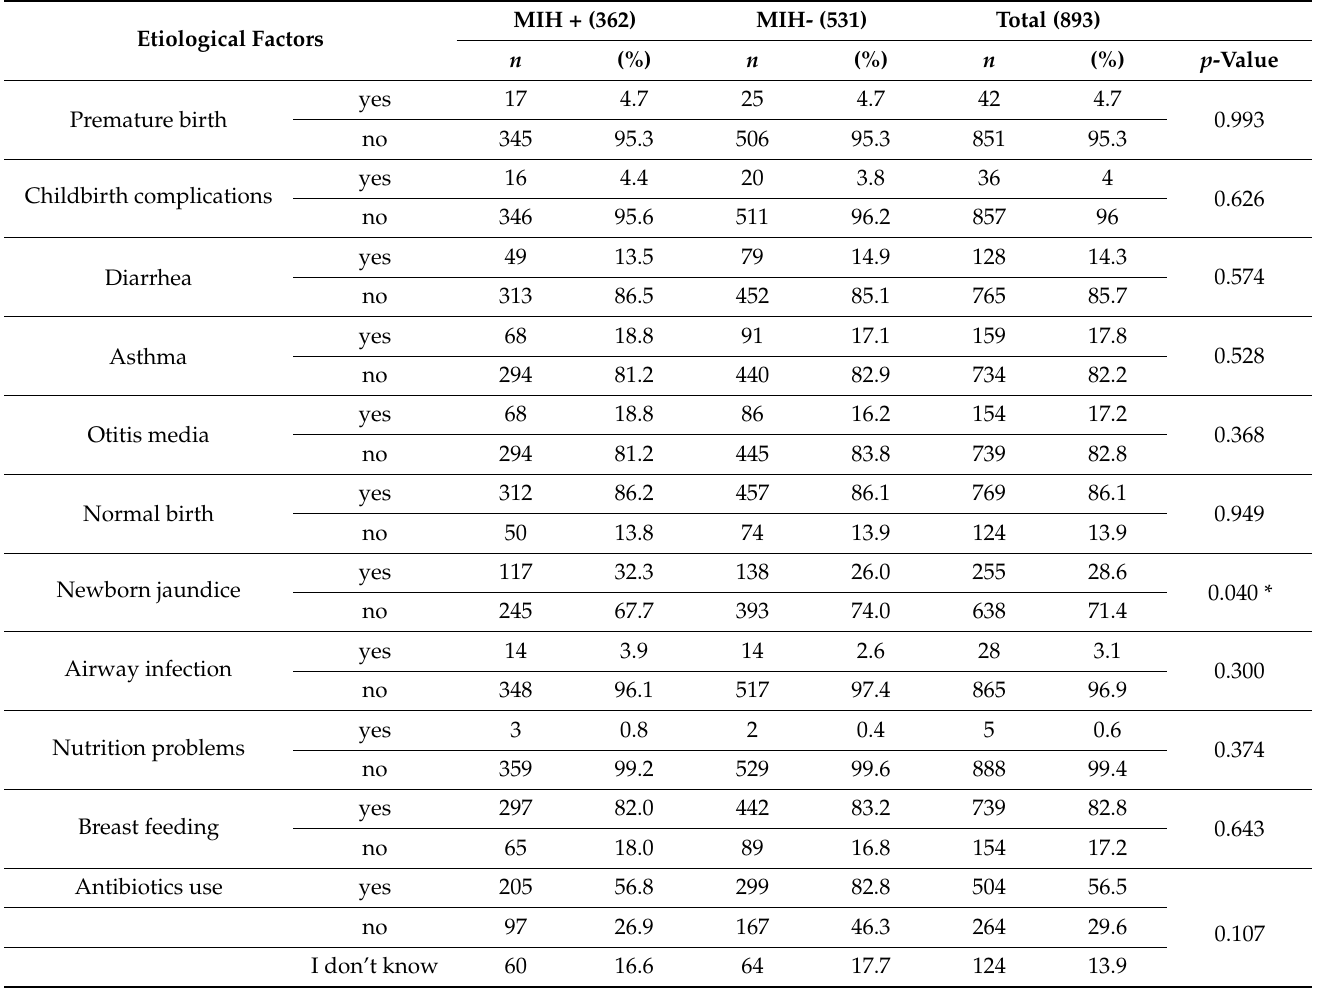
Table 3. Distribution of etiological factors in children with and without MIH.